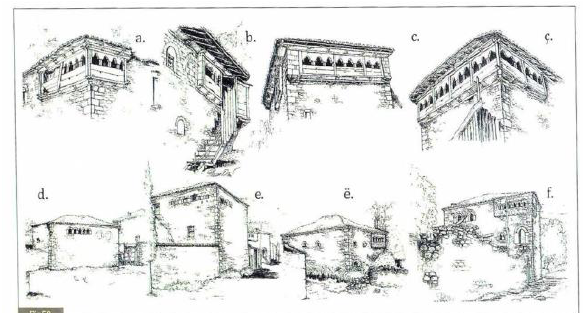
Figure 1. Typical traditional tower-houses of Kosovo ( kulla ) in drawings by the architectural historian Flamur Doli (Source: 2009, Arkitektura Vernakulare Kosoves , p. 193)